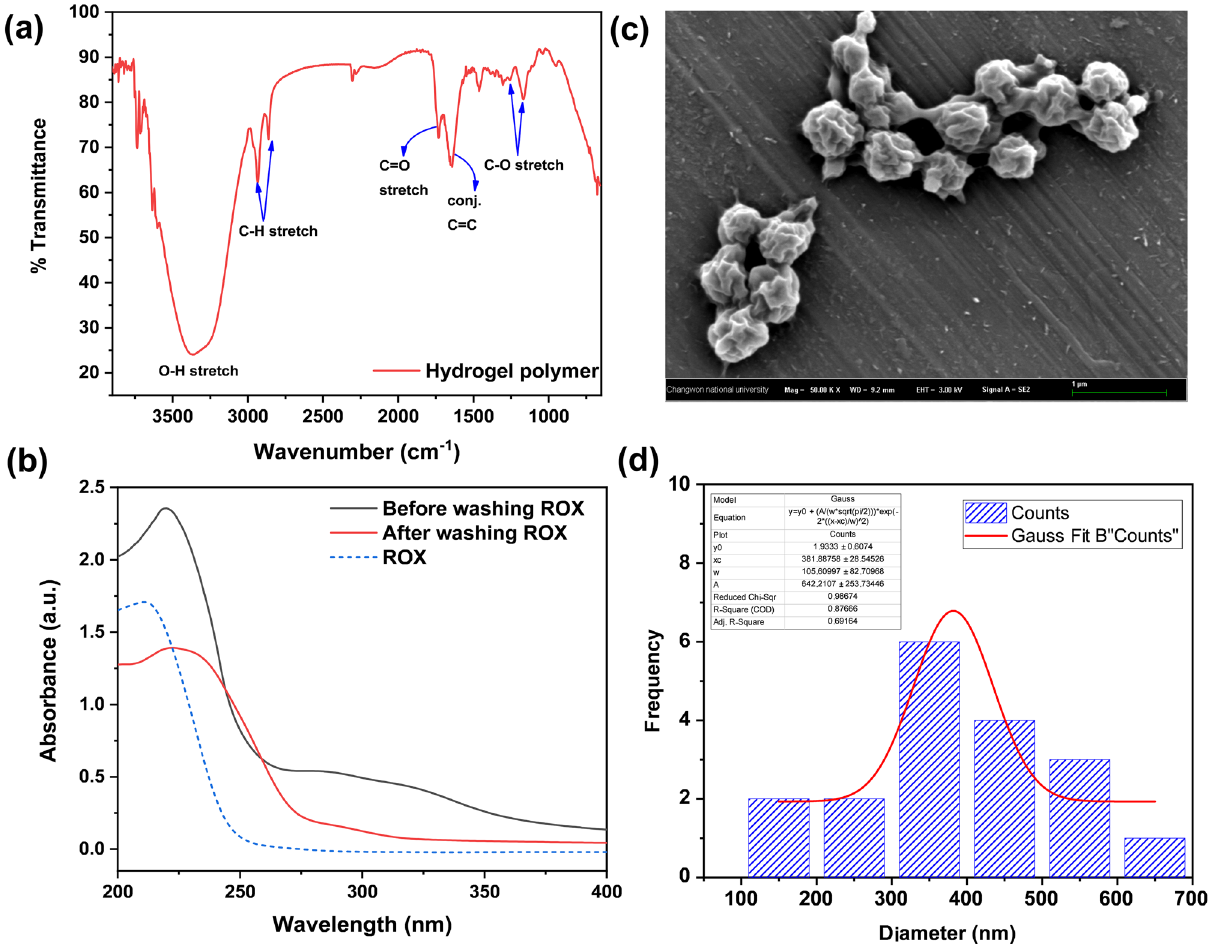
Figure 3. Characterization of MIP nanogels through FTIR ( a ) and UV–Vis spectrometry ( b ). LV-SEM image ( c ) and size distribution of MIP nanogels ( d